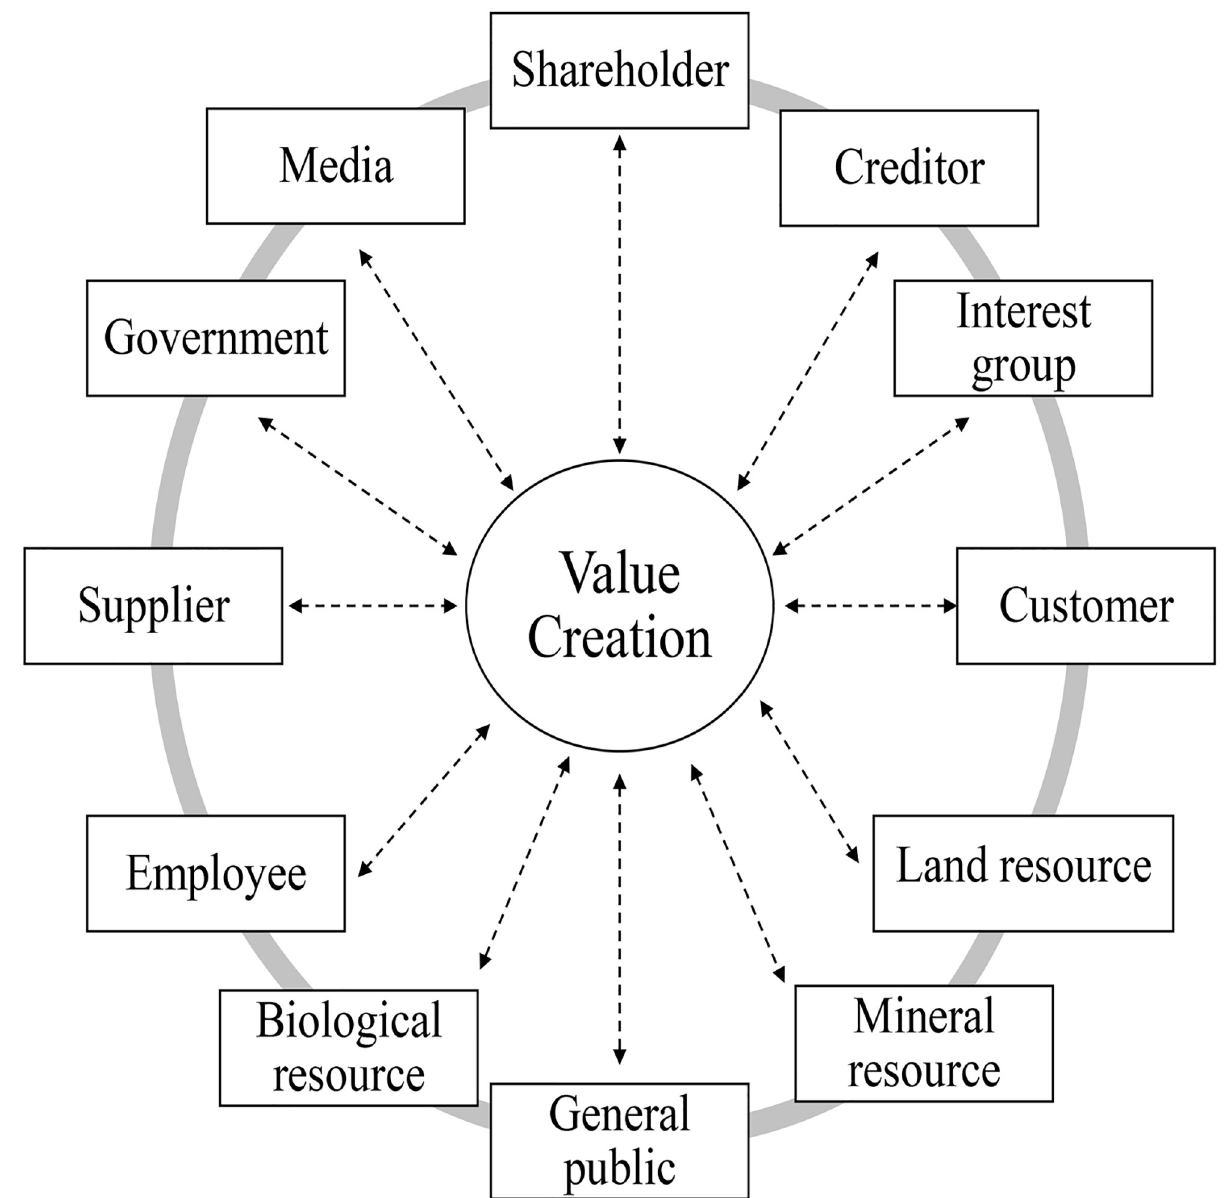
Fig 3. Interaction between stakeholders in value